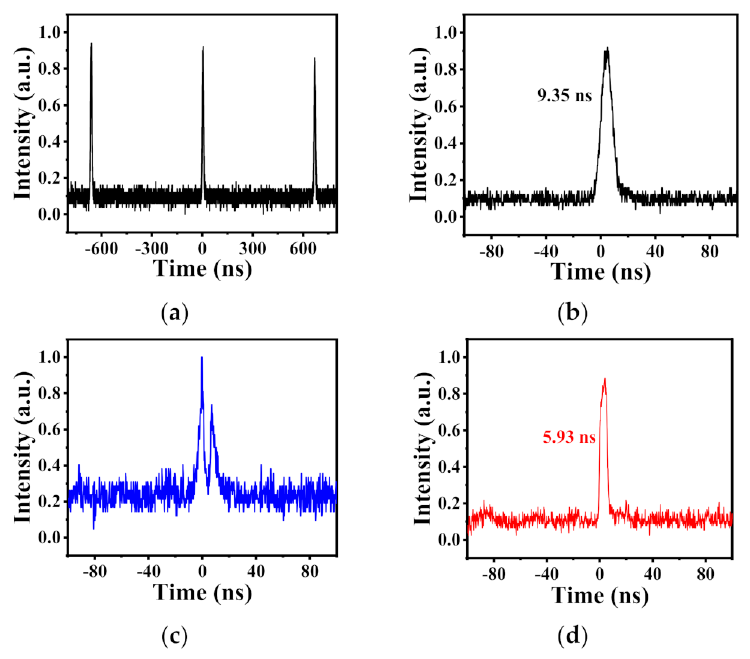
Figure 5. ( a ) The pulse train of pump laser; the pulse shape of ( b ) pump laser, ( c ) residual pump laser and ( d ) Raman